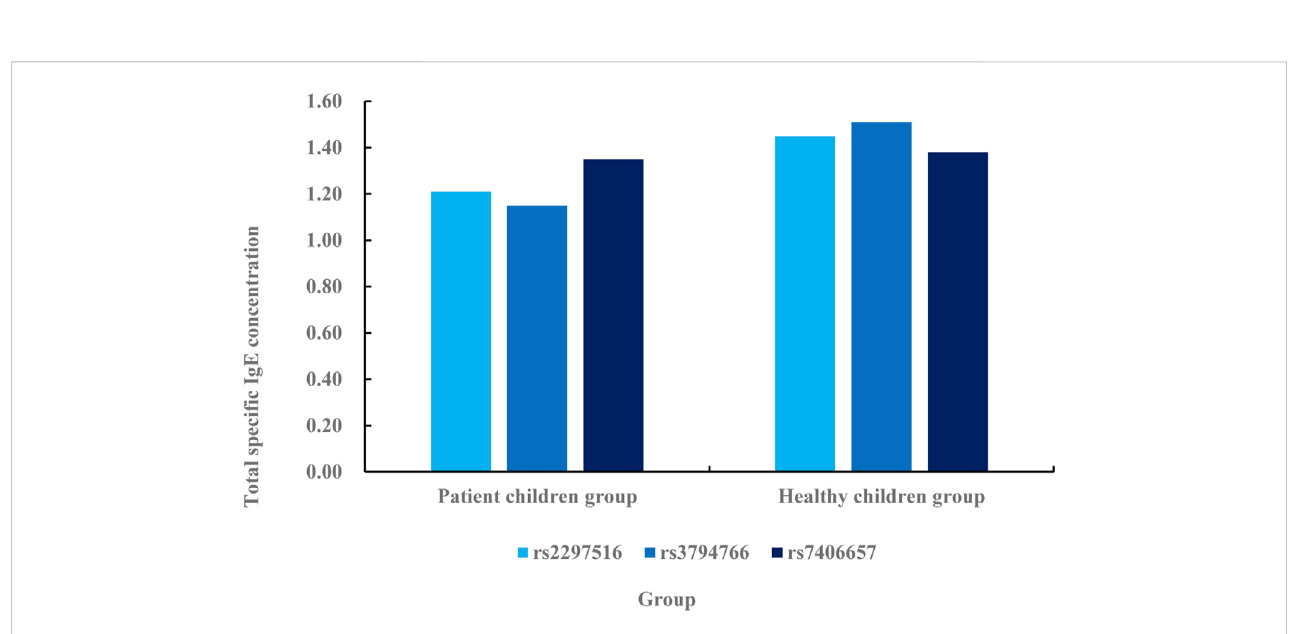
FIGURE 6 Association between NOS2 gene SNP and speci fi c